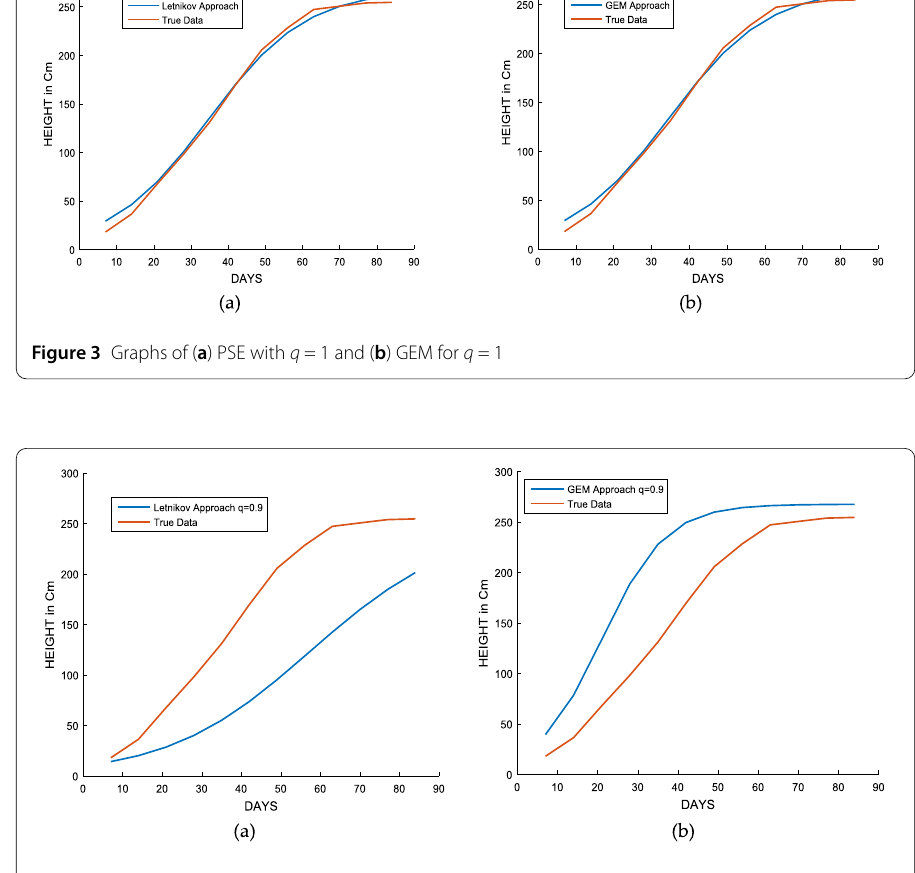
Figure 4 Graphs of ( a ) PSE with q = 0.9 and ( b ) GEM for q =